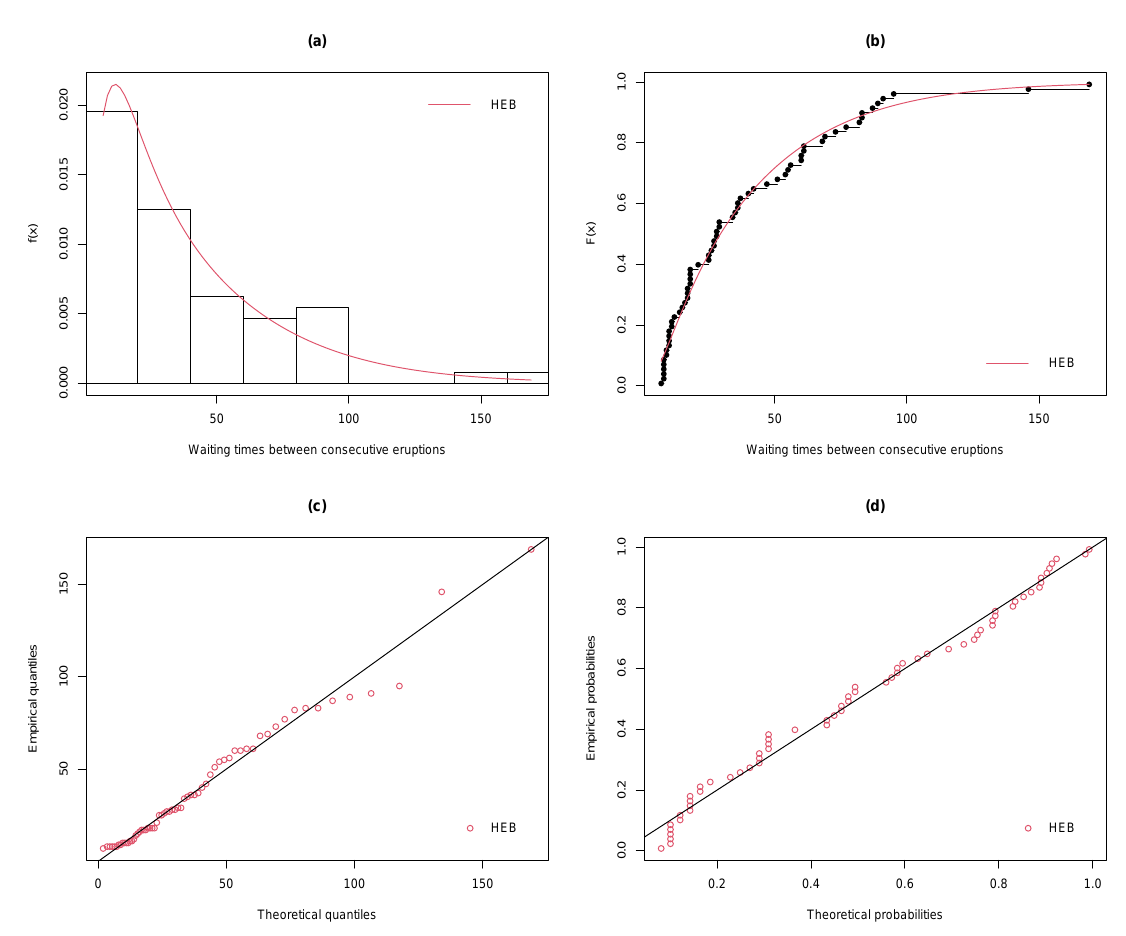
Figure 6. The fitted pdf ( a ), cdf ( b ), Q-Q plot ( c ), and P-P plot ( d ) of the HEB model for the Kiama Blowhole